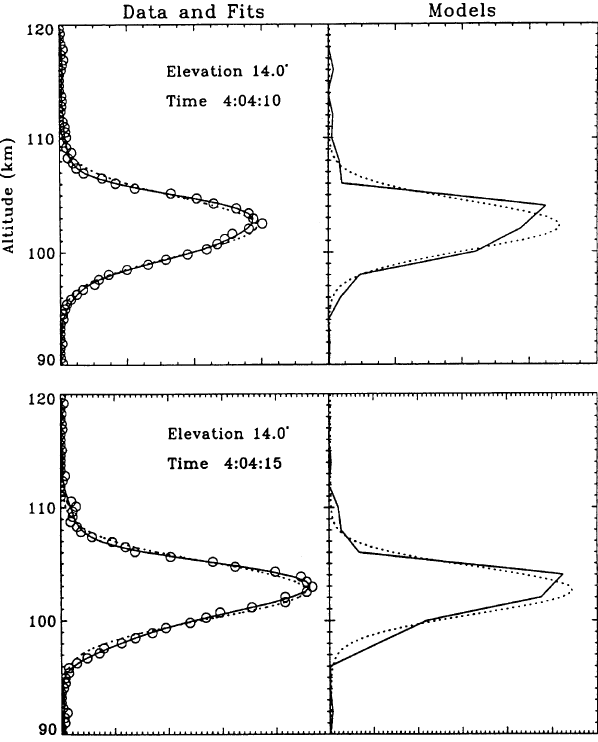
Fig. 2. Example of scattering profile estimation. See text for